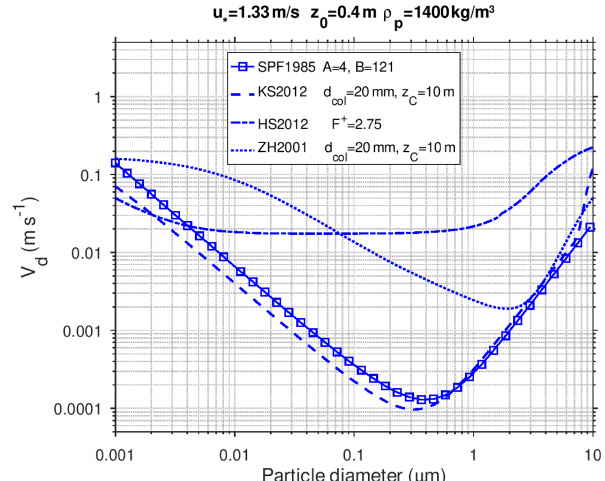
Figure 4. Dry deposition of particles over a rough urban surface cal- culated with the SPF1985 scheme (solid line with squares), KS2012 scheme (lower dashed line), HS2012 scheme (upper dashed line), and ZH2001 scheme (dotted line) using u ∗ = 1 . 33ms − 1 , z 0 = 0 . 4m, and an average particle density of 1400kgm − 3 . Specific pa- rameter values are given in the legend.